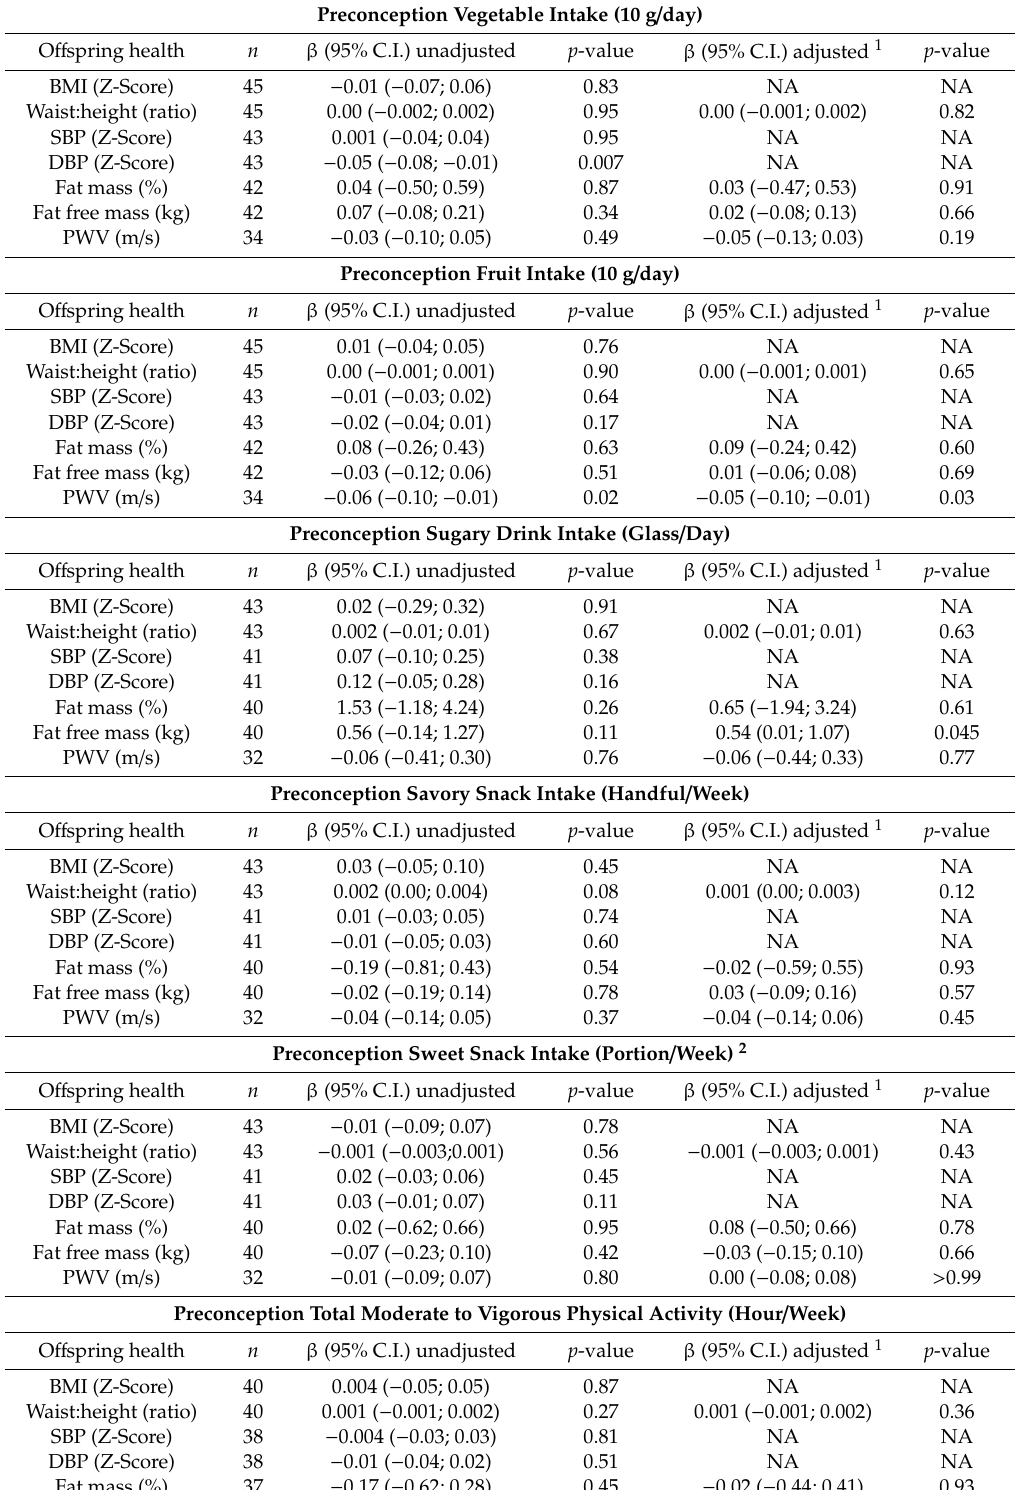
Table 3. Linear regression analyses of preconception diet and physical activity and o ff spring cardiovascular health at age 3–6